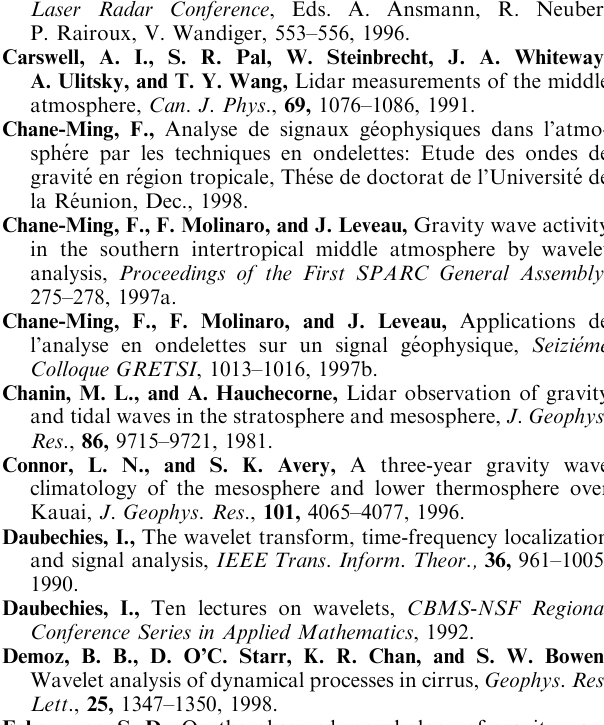
scaling function and the wavelet respectively in the direct space. The synthesis filters ( h ¢ ( n ) and g 0 ( n )) are chosen to produce a perfect reconstruction and can be obtained by transposing the analysis FIR filters.